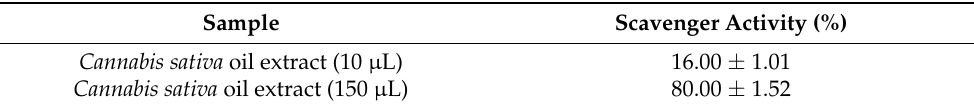
Table 1. Antioxidant activity of Cannabis sativa oil extract calculated as the inhibition percentage of DPPH radical.